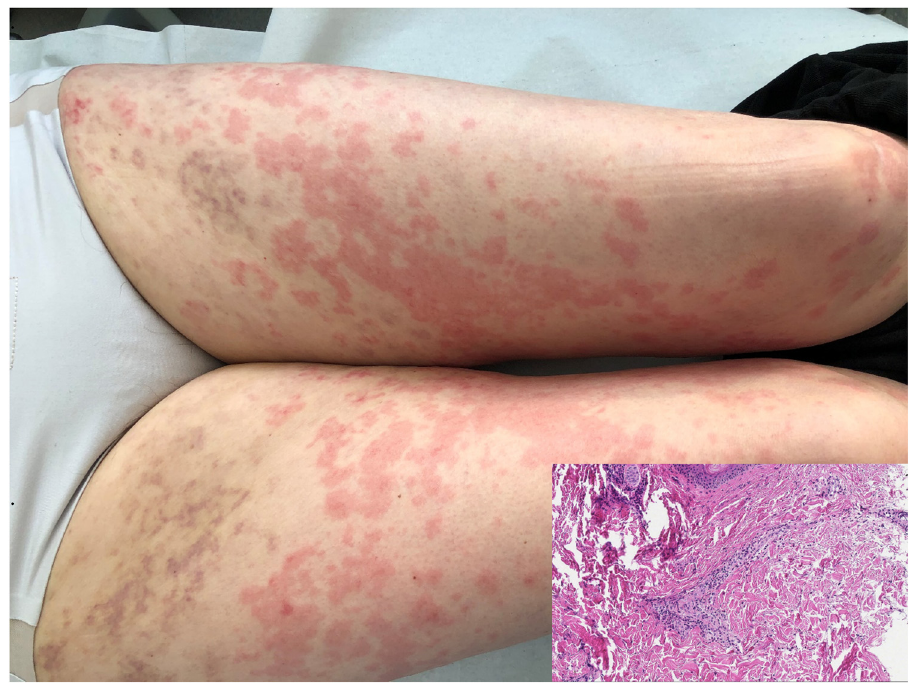
Figure 1: Urticarial and palpable non - blanching purpuric rash compatible with mild mixed perivascular in fi ltration of lymphocytes and neutrophils in the super fi cial dermis, oedema of blood vessels endothelium, no vessels wall necrosis identi fi